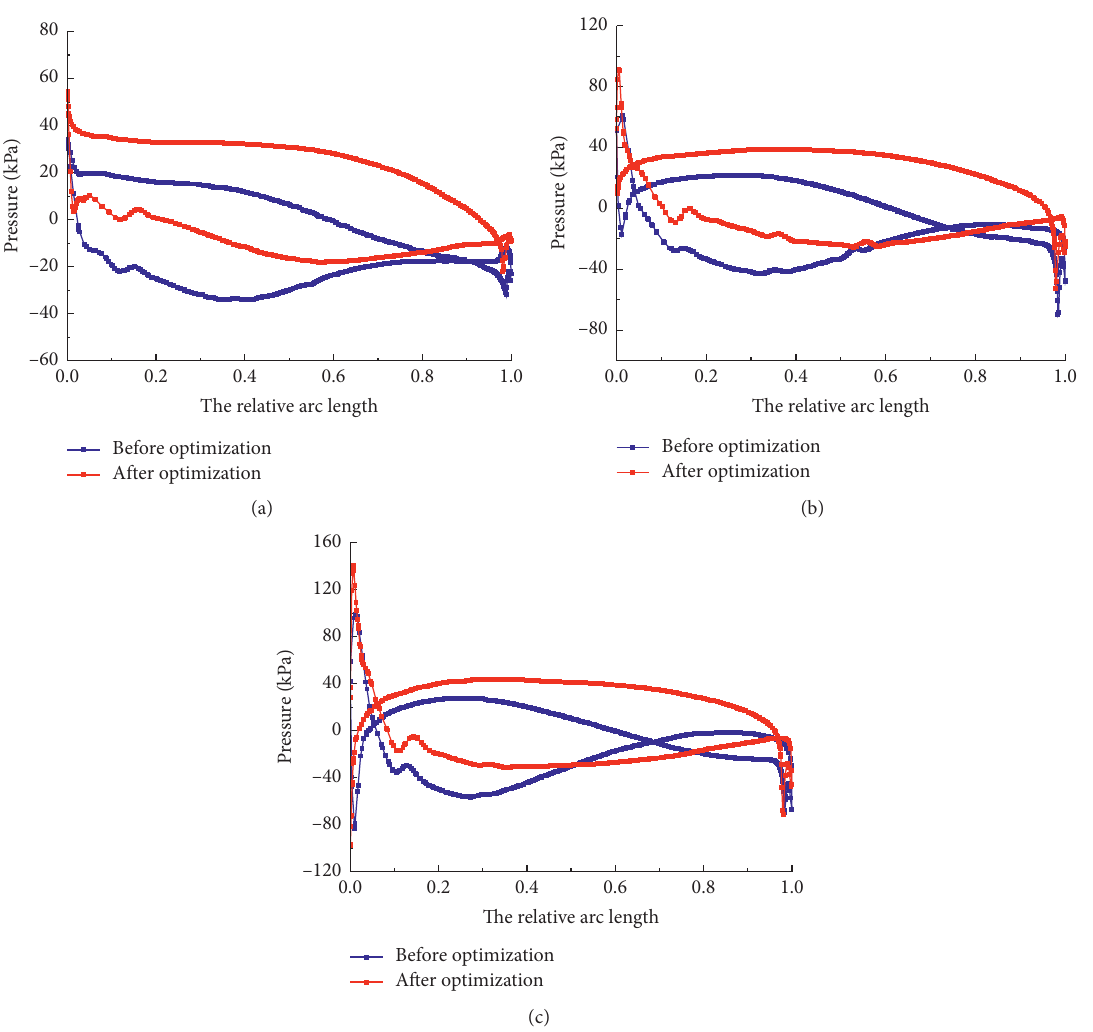
Figure 15: Static pressure distribution on the blade surface before and after optimization: (a) span � 0.25; (b) span � 0.5; (c) span � 0.75.